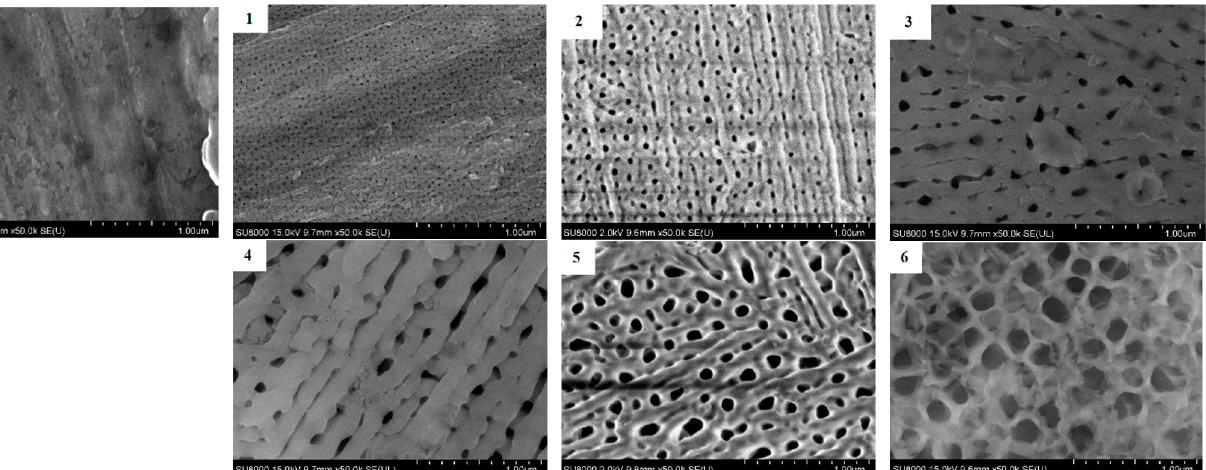
Figure 6. SEM images of anodized aluminum foil samples, anodizing conditions and sample numbers are shown in Table 1. The nanoperforations diameters are: ( 0 )–aluminum without anodizing; ( 1 )–10 nm; ( 2 )–30 nm; ( 3 )–50 nm; ( 4 )–70 nm; ( 5 )–100 nm; ( 6 )–150 nm.